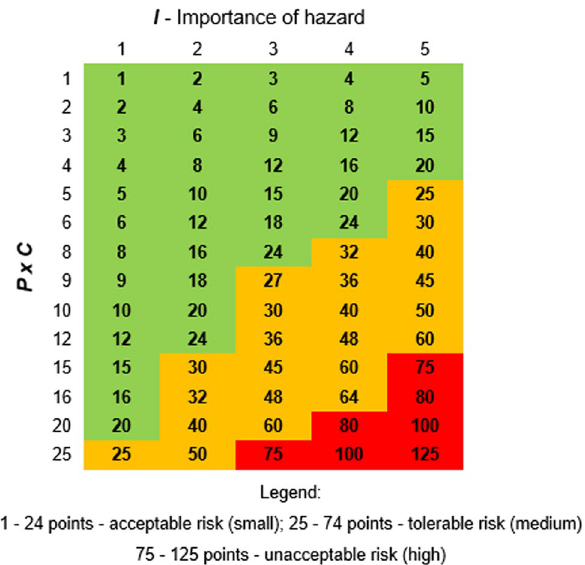
Fig.3 Risk assessment matrix according to the proposed